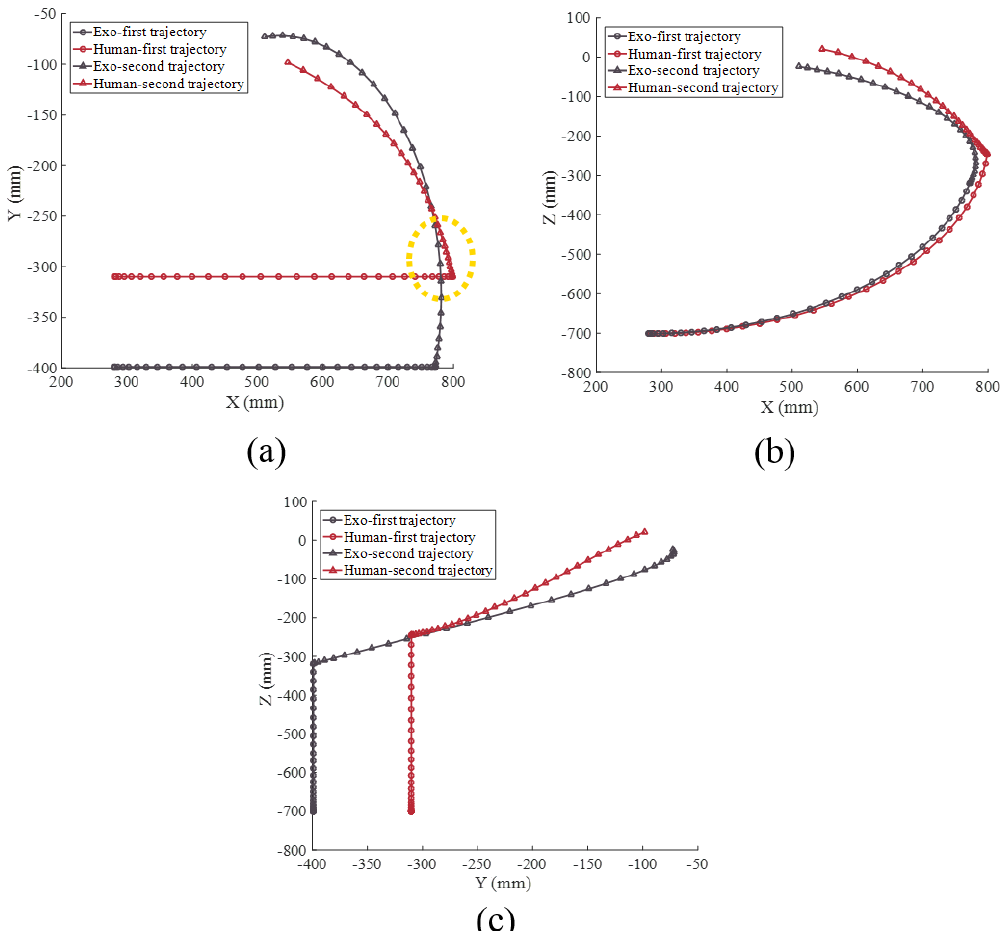
Figure 15. The drinking trajectories of the exoskeleton and the upper limb.